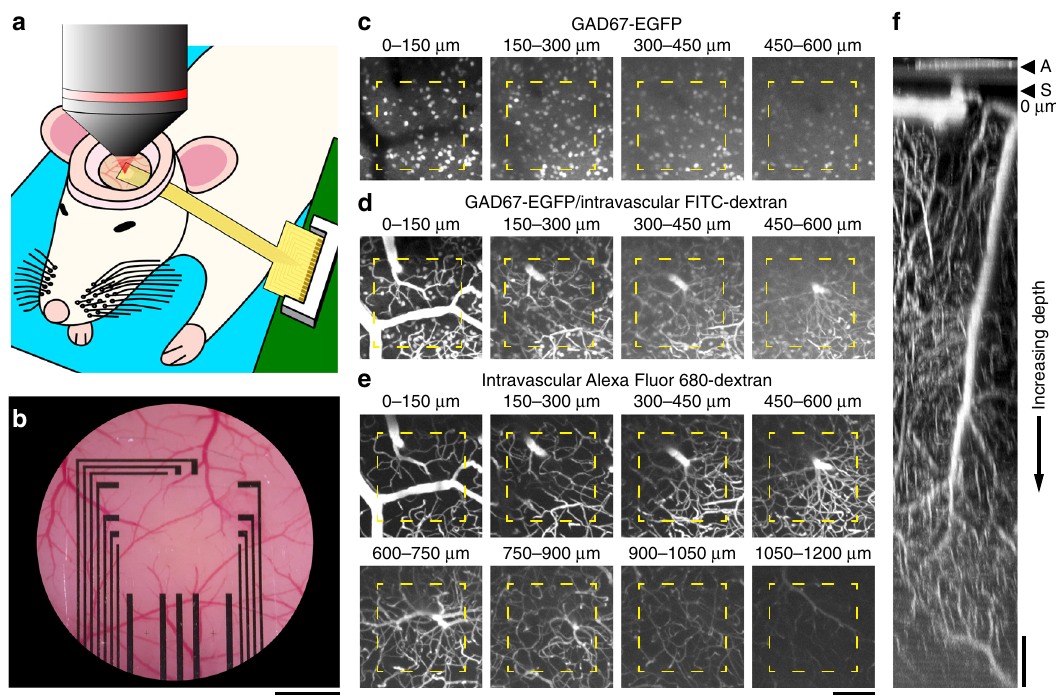
Fig. 2 Structural 2-photon imaging through a graphene microelectrode array. a After placement of head-post (not shown), craniotomy, and dura removal, the graphene microelectrode array is placed on the surface of the primary somatosensory cortex (SI). The exposure is covered with agarose and closed with a coverslip. Dental acrylic is used to fi x the coverslip and the arrays ’ connecting wires to reduce motion. b Bright- fi eld image of an exposure with graphene microelectrode array. Graphene electrodes and wires in the center of the array are not visible, but the gold wires for connection to the ampli fi er board. Scale bar, 500 µ m. c Detection of EGFP-expressing interneurons in GAD67-GFP mice below a single graphene electrode (yellow outline). Images were acquired using 2-photon excitation at 905 nm (laser power from 3 mW at the surface to 57 mW at 600 µ m cortical depth). d The same region as in c is shown, but after intravascular injection of FITC-dextran (2 MDa); images were acquired using 2-photon excitation at 950 nm (laser power from 8 mW at the surface to 77 mW at 600 µ m cortical depth). e The same region as in c , d is shown, but after additional intravascular injection of Alexa Fluor 680- dextran (2 MDa); images were acquired using 2-photon excitation at 1280 nm (laser power from 2 mW at the surface to 44 mW at 1200 µ m cortical depth). c – e Show maximum intensity projections (MIPs) of images acquired at different depths (step size: 3 µ m) below the cortical surface (MIP range is indicated above individual images). Scale bar for c – e , 100 µ m. f Orthogonal (XZ) MIP of the Alexa Fluor 680-dextran dataset shown in e ; graphene microelectrode array (A) and cortical surface (S) are on the top of the image. Scale bar, 100 µ